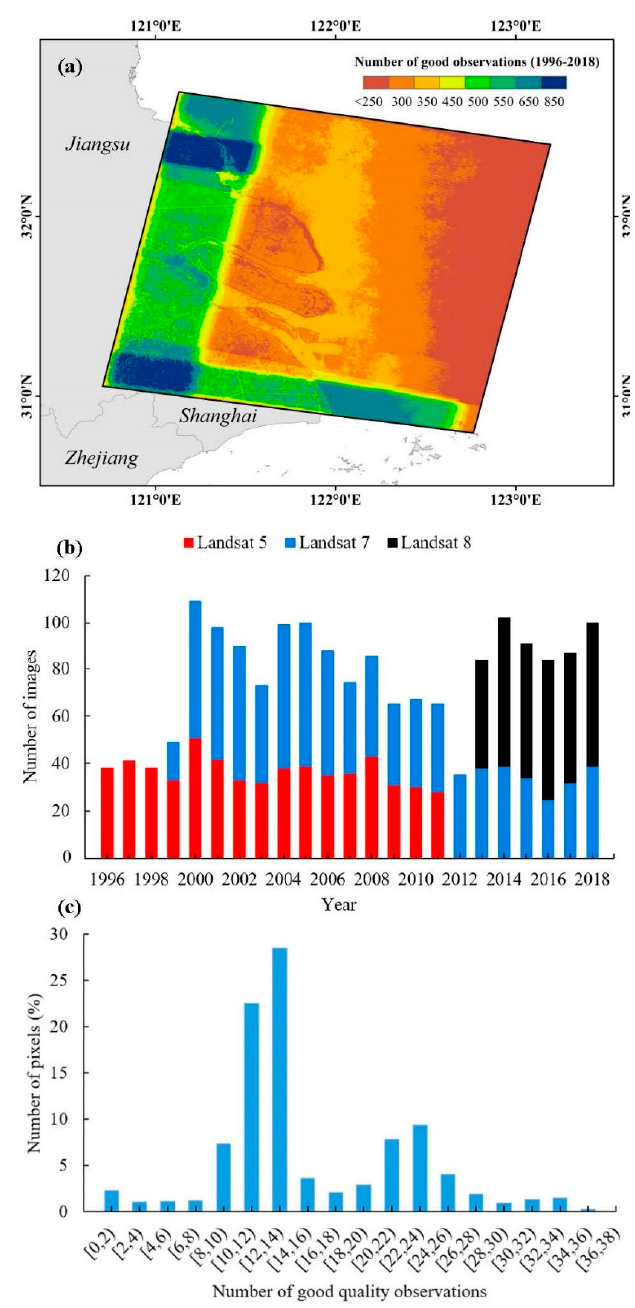
Figure 3. Availability of time series Landsat images from 1996 to 2018: ( a ) number of good-quality observations of all Landsat images (path: 118, row: 38); ( b ) number of Landsat 5/7/8 images from 1996 to 2018 used in this study; ( c ) distribution of annual good-quality observations of all pixels from 1996 to 2018.